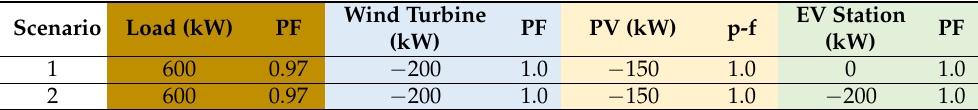
Figure 20. Measured voltage and transformer loading at the primary side. Table 3. Test set points for the use case